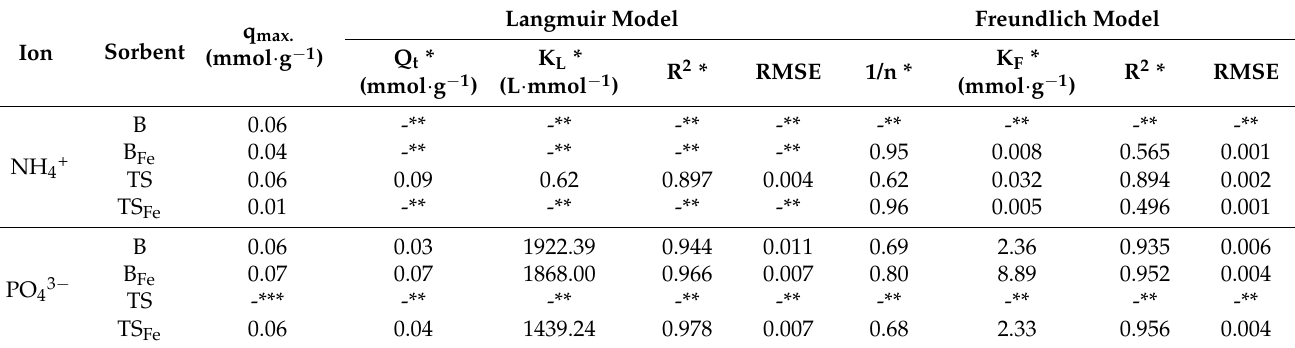
Table 2. Adsorption parameters for NH 4+ and PO 43- on B, TS, B Fe and TS Fe .